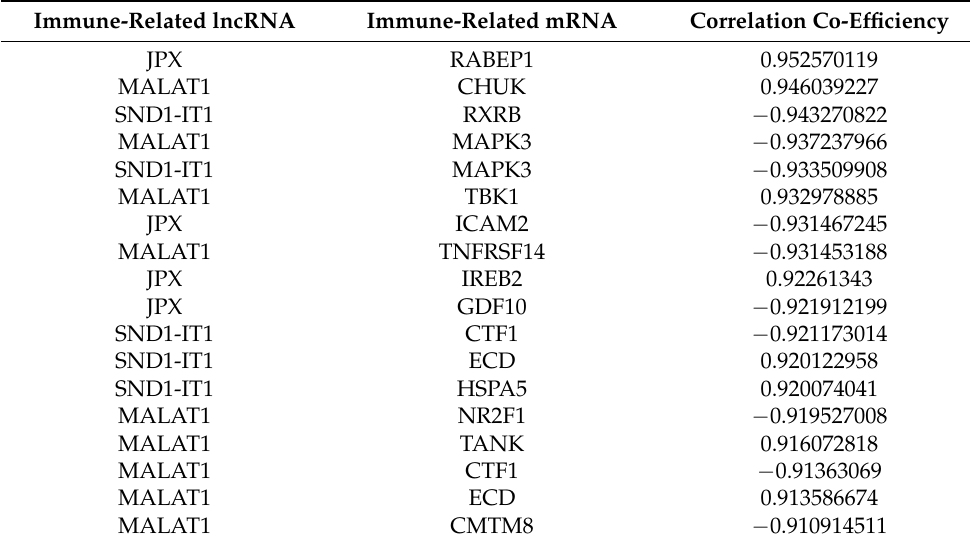
Table 1. The lncRNA-mRNA pairs with |correlation co-efficiency| > 0.91 in the co-expression